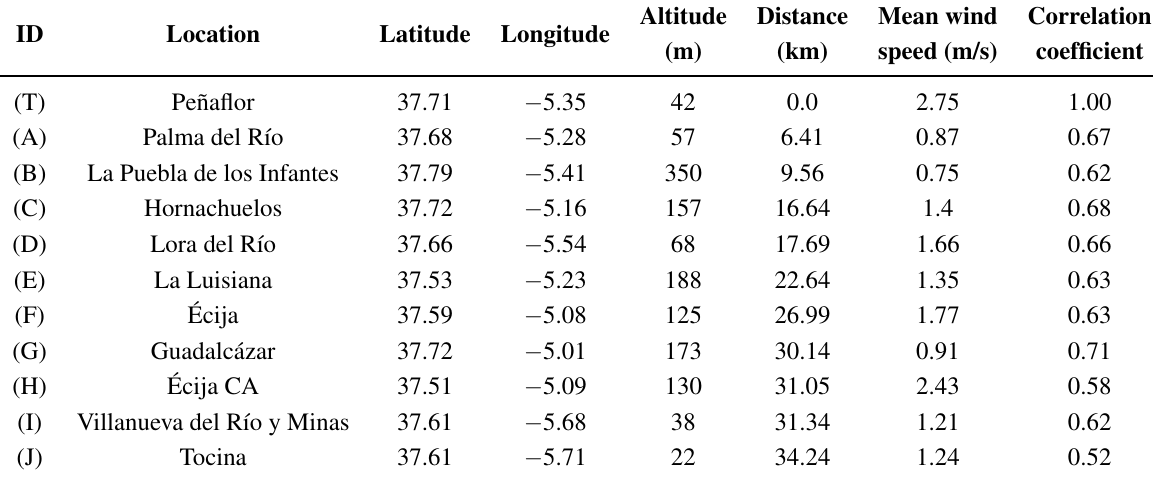
Table 2. Information of the used stations in this